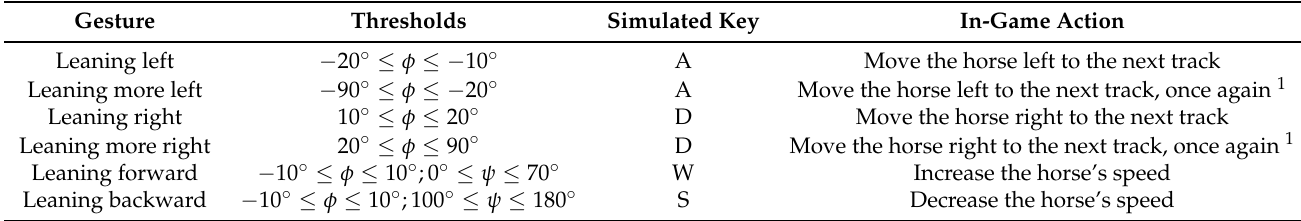
Table 2. Gestures, threshold, simulated keyboard press, and in-game action.